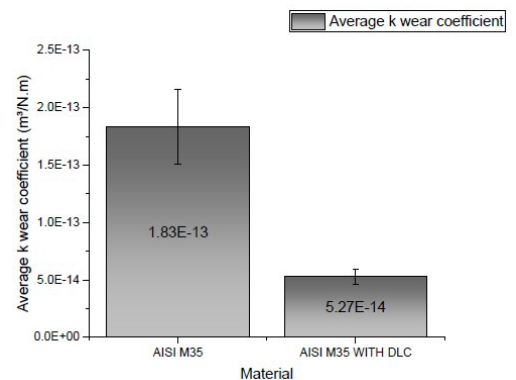
Figure 9. Wear coefficient assessed on the AISI M35 HSS substrate with and without DLC coating.